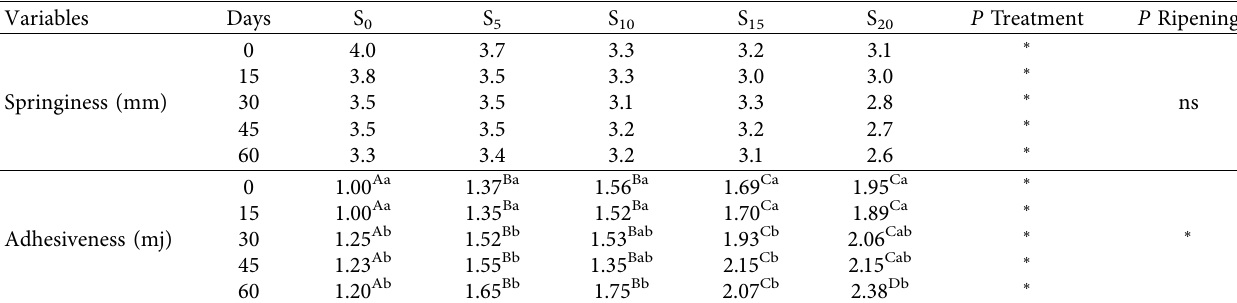
Table 7: The microbial properties of Fruit whey less Feta-type cheeses produced using different percentages of pomegranate juice (S S 15 , and S 20 , respectively, containing 0, 5, 10, 15, and 20% of pomegranate juice). Variables P Treatment P Ripening Mesophilic lactobacilli (log 10 cfu/g)